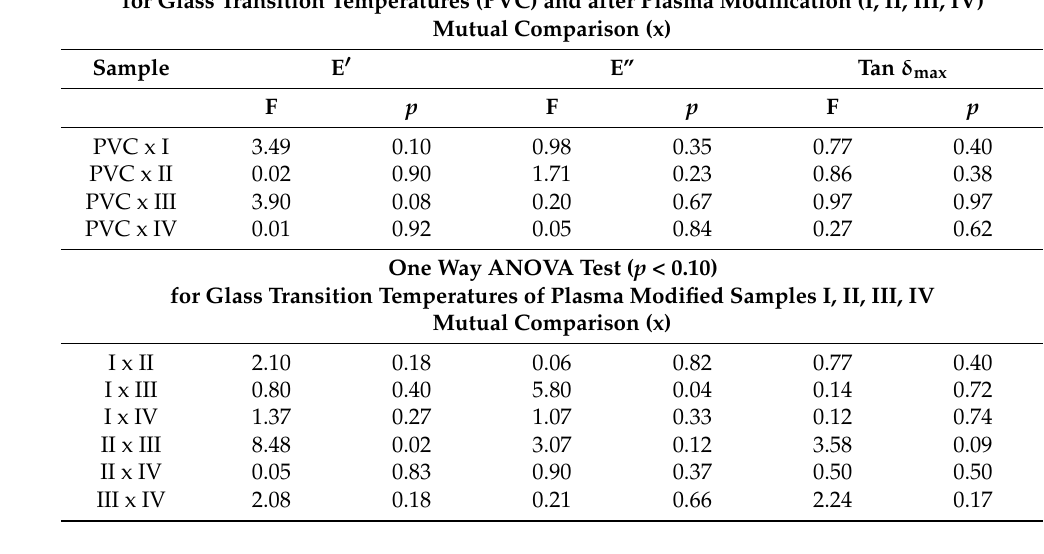
Table 5. Results of One Way ANOVA test of glass transition temperatures from DMA analysis. One Way ANOVA Test ( p < 0.10) for Glass Transition Temperatures (PVC) and after Plasma Modification (I, II, III,